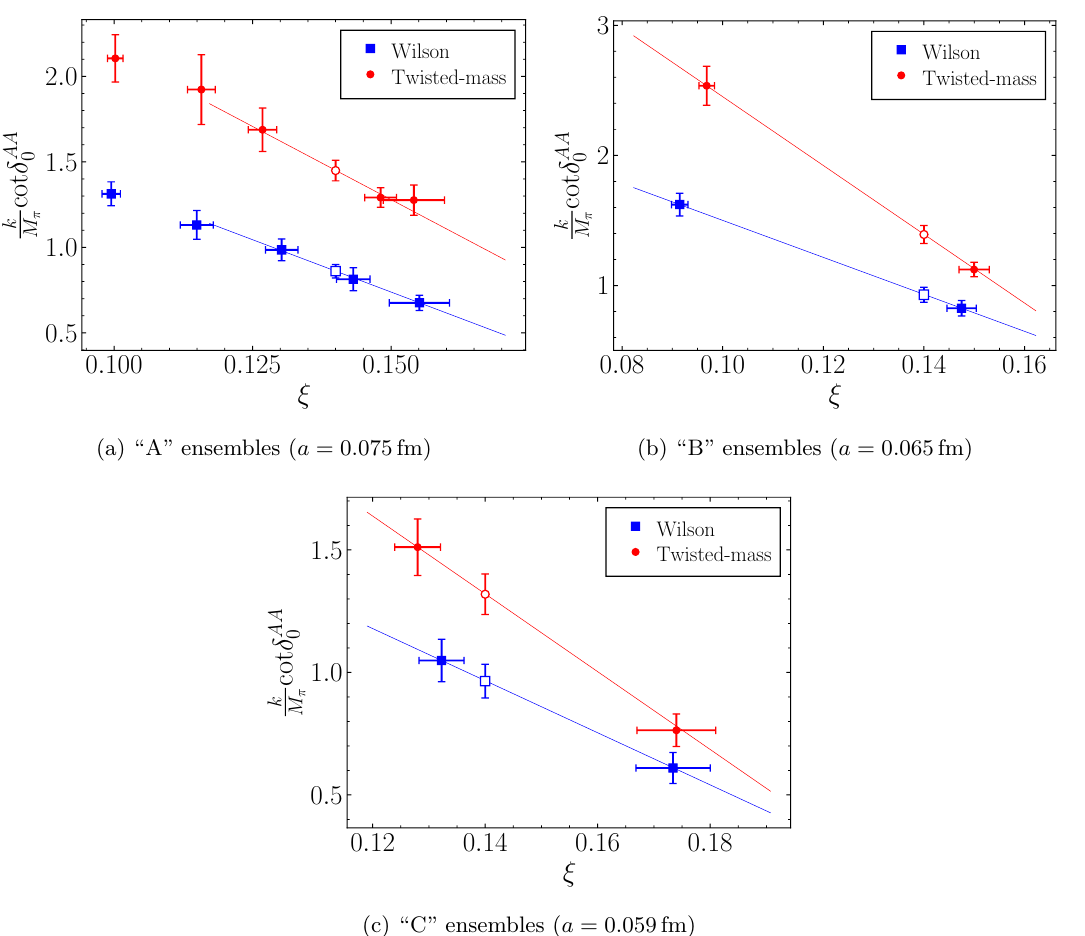
Figure 9 . Results for the linear interpolation of ( kM π ) cot δ 0 to a fixed value ξ ref = 0 . 14 , depicted as empty pointd, for the pure Wilson (blue) and mixed-action (red) setups, and for the three lattice spacings. In the coarser case, only three points are used in the